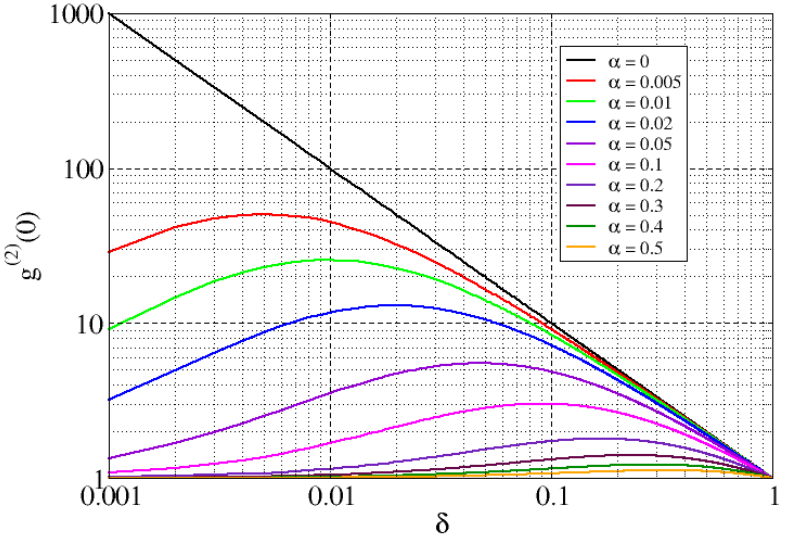
Figure 3. Zero-delay second-order autocorrelation, Equation (4), in double logarithmic scale, as a function of the duty cycle δ , and for different values of the baseline’s amplitude α (fraction of the peak amplitude A